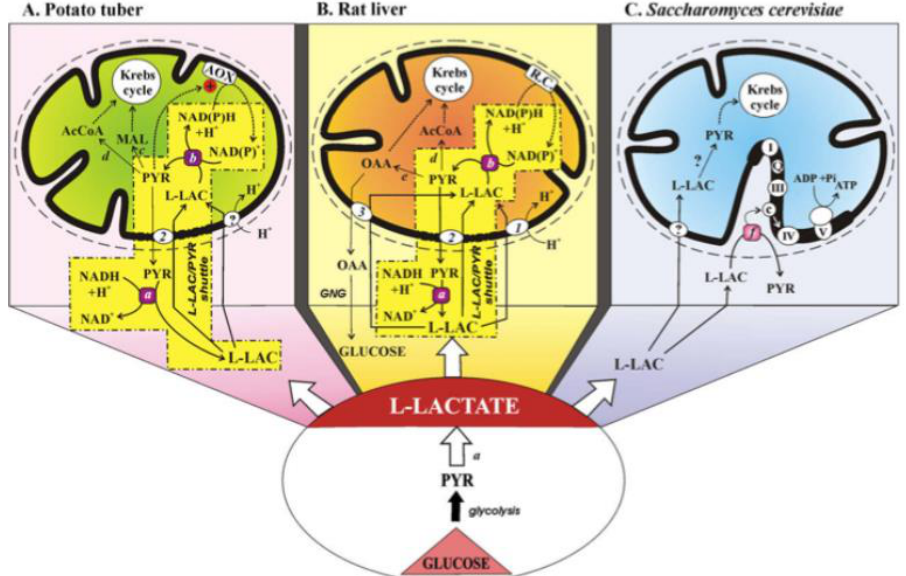
Figure 11. The mitochondrial metabolism of L-lactate. From Passarella et al. From [10]. With permission from John Wiley and Sons, 2021.